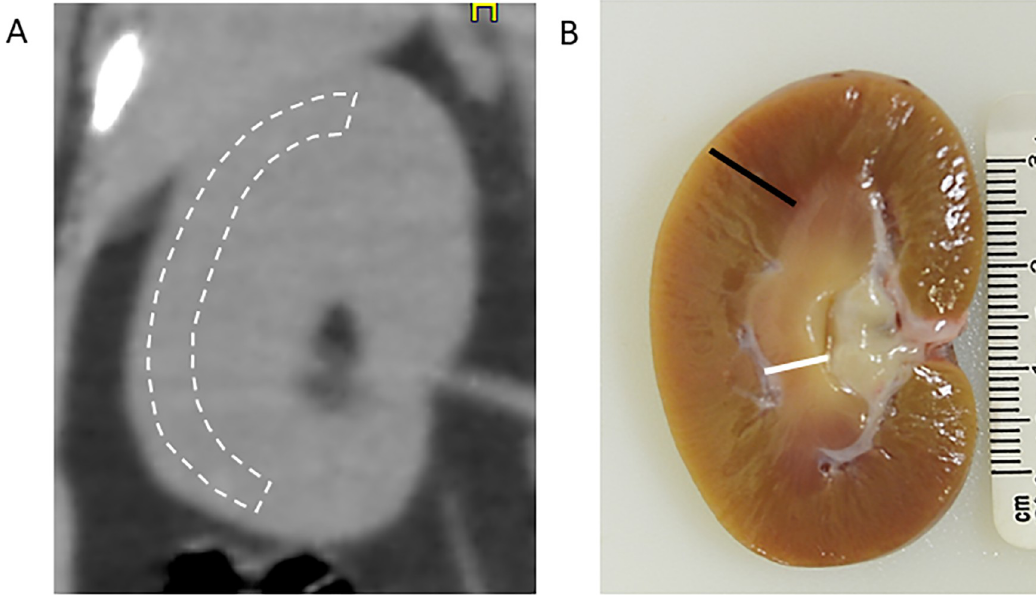
Fig 3. Regions of interest and kidney anatomy. A) Renal Cortex ROIs were manually traced in three slices of a coronal reconstruction of each CT data set to get the average CT number of the renal cortex. B) Shows a sagittal view of a rhesus monkey kidney. A black line indicates the cortex and a white line indicates the